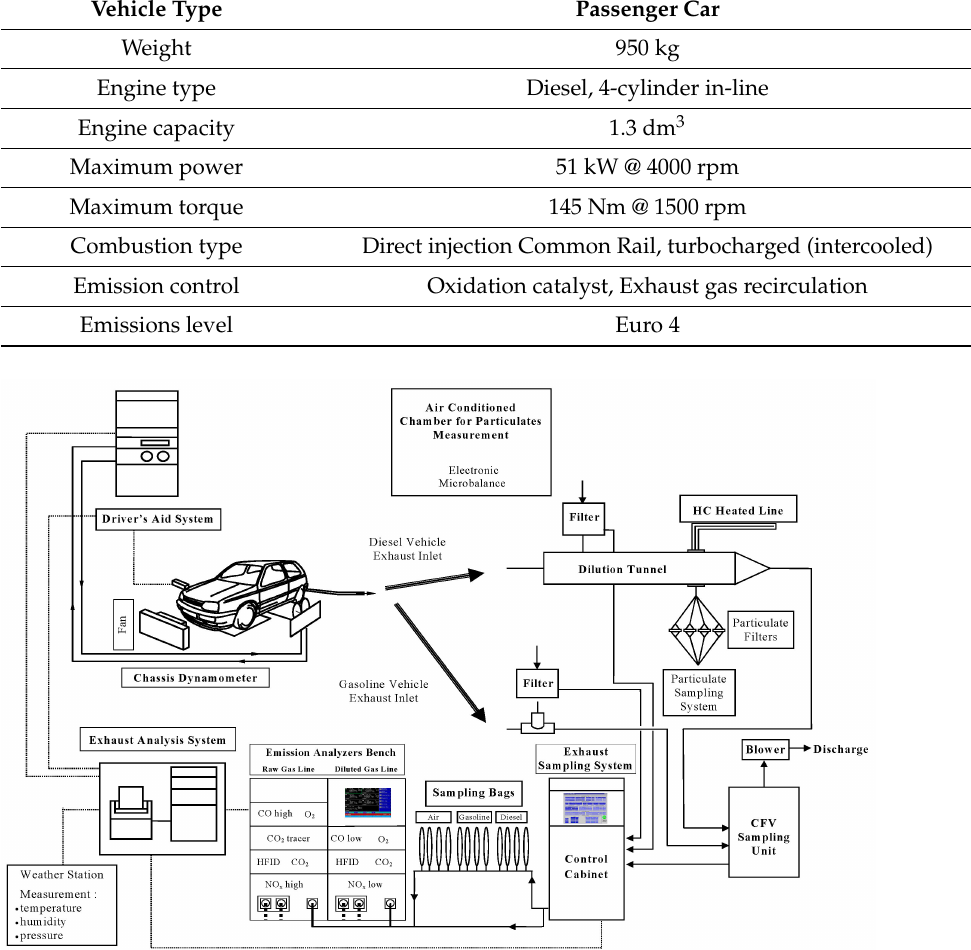
Figure 3. Chassis dynamometer and schematic of exhaust emissions measurement